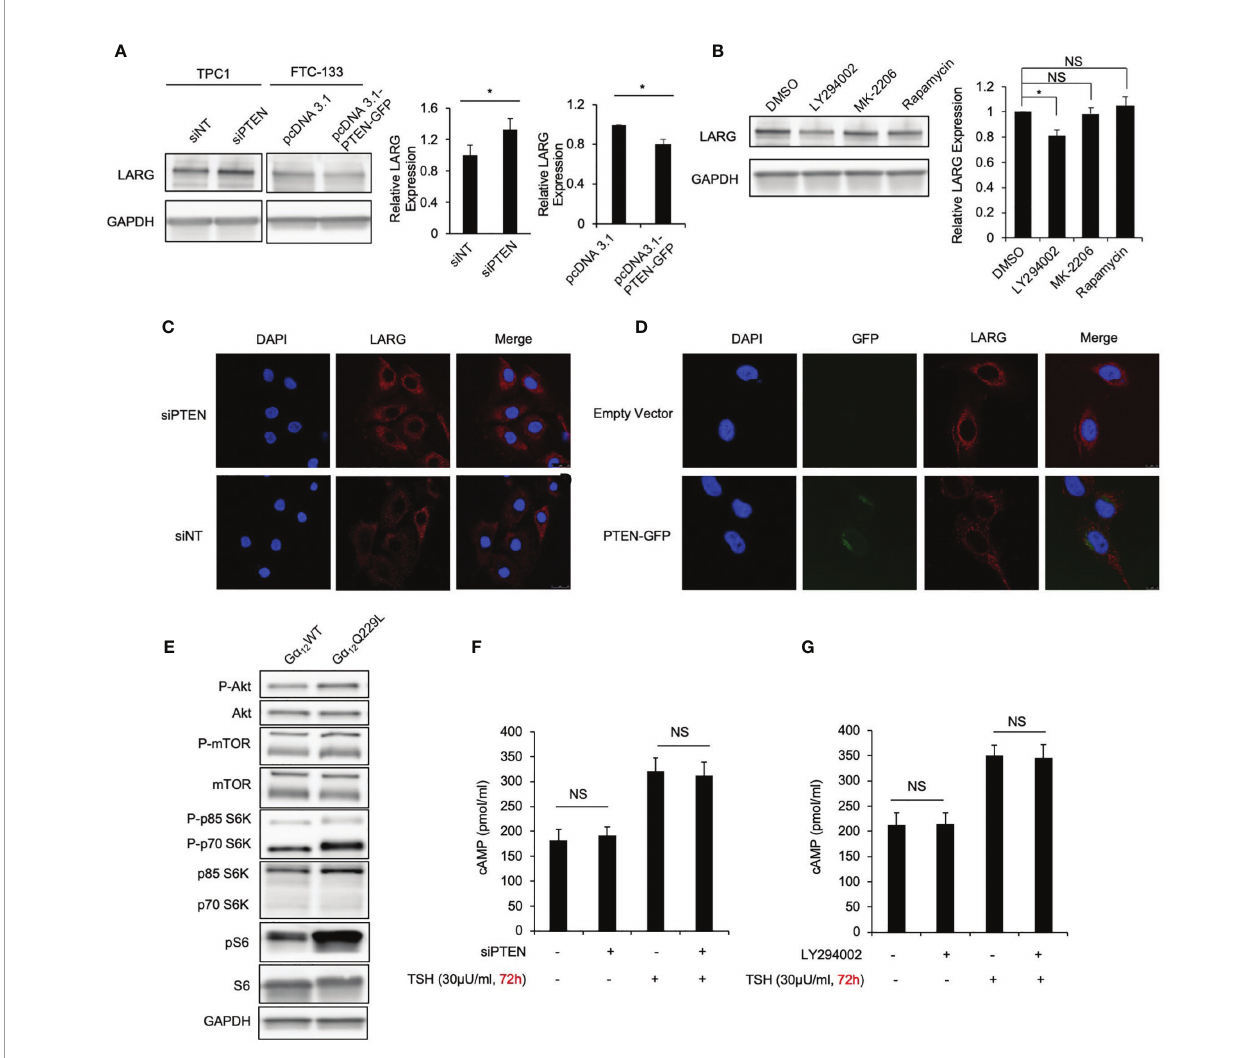
FIGURE 6 | PTEN/PI3K is associated with LARG levels and submembrane localization in thyroid cancer cells. (A) Immunoblot of LARG using total lysate from TPC1 cells transiently transfected with siNT or siPTEN, and FTC-133 cells transiently transfected with empty vector or PTEN plasmid for 72 hours. GAPDH was used as a loading control. Bar chart shows the relative LARG protein levels in TPC1 after siPTEN knockdown compared to control, and in FTC-133 cells after PTEN transfection compared to control. Data represent means ± SEM of 3 independent experiments. (B) Immunoblot of LARG in TPC1 cells treated with LY294002, MK-2206, rapamycin or DMSO. Bar chart, LARG protein levels normalized to GAPDH. Data represent means ± SEM of 3 independent experiments. (C) Confocal microscopy of LARG immuno fl uorescence staining in TPC1 cells transiently transfected with siNT or siPTEN for 72 hours. Scale bar, 25 µm. Data are representative of 3 sets of independent experiments. (D) Confocal microscopy of LARG immuno fl uorescence staining in FTC-133 cells transiently transfected with PTEN-GFP or empty vector for 48 hours. Scale bar, 10 µm. Data are representative of 3 sets of independent experiments. (E) Immunoblot of phospho-Akt, Akt, phospho-mTOR, mTOR, phospho-p70 S6K, p70 S6K, phosphor-ribosomal S6, ribosomal S6 and GAPDH in TPC1 cells stably transfected with G a 12 Q229L or G a 12 WT. Data are representative of 3 sets of independent experiments. (F) Bar chart, cAMP levels in TPC1 cells transiently transfected with siNT or siPTEN, with or without TSH for 72 hours. Data represent means ± SEM of 3 independent experiments. (G) Bar chart, cAMP levels in TPC1 cells treated with PI3K inhibitor LY294002 or DMSO, with or without TSH for 72 hours. Data represent means ± SEM of 3 independent experiments. * P < 0.05, NS, not signi fi